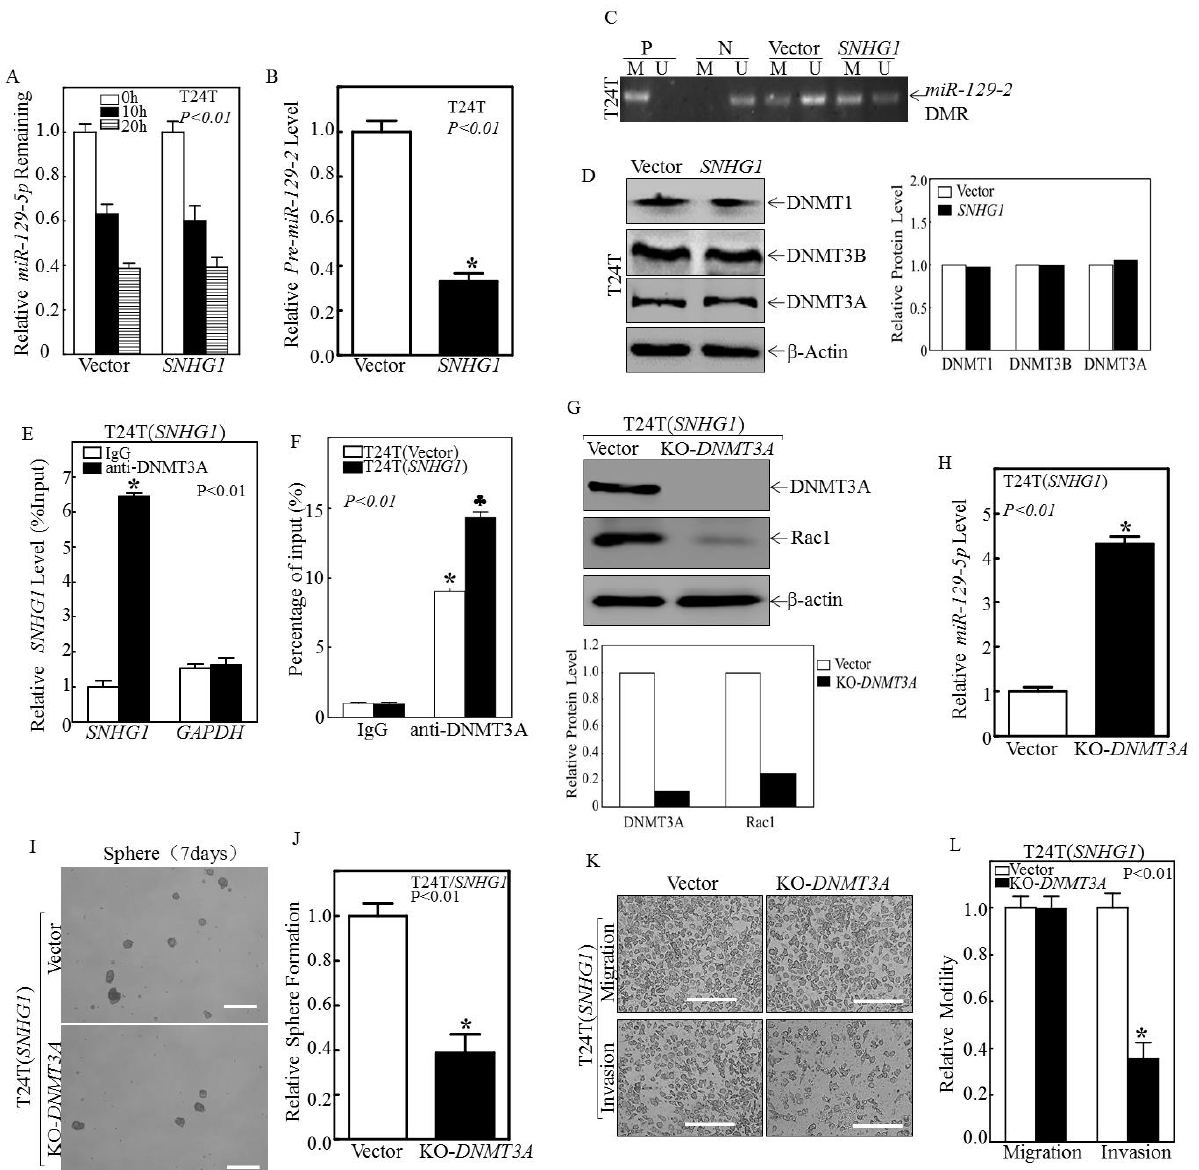
Figure 4. SNHG1 bound to DNMT3A protein and promoted the interaction of DNMT3A with the miR-129-2 promoter, thereby hyper-methylating and inhibiting the transcription of miR-129-2. ( A ) T24T(Vector) and T24T(SNHG1) cells were incubated with Act-D for 0, 10, and 20h. Total RNA was isolated and then subjected to quantitative real-time PCR to determine miR-129-5p levels. ( B ) Quantitative real-time PCR was carried out to determine the expression of pre-miR-129-2 in the indicated cells. ( C ) The methylation status of the miR-129-2 promoter in the differentially methyl- ated region (DMR) was determined using a methylation-specific PCR (MS-PCR) assay. Two primer sets were used to evaluate the methylated (M) and unmethylated (U) copies of the miR-129-2 DMR gene. Methylated DNA was used as the positive control (P), while unmethylated DNA was used as the negative control (N). PCR products represented the methylated state and unmethylated allele. ( D , Left panel) Total protein extracts from the indicated cells were extracted and subjected to Western blotting for DNMT1, DNMT3A, and DNMT3B, with β -Actin as a loading control. ( D , Right panel) Relative protein levels determined by densitometry and expressed as ratios versus β -Actin. ( E ) RNA-IP was carried out to examine the specific interaction of SNHG1 with DNMT3A. GAPDH was employed as a negative control. ( F ) ChIP assays were performed to determine DNMT3A binding to the miR-129-2 promoter in T24T(Vector) and T24T(SNHG1) cells (see Mate-